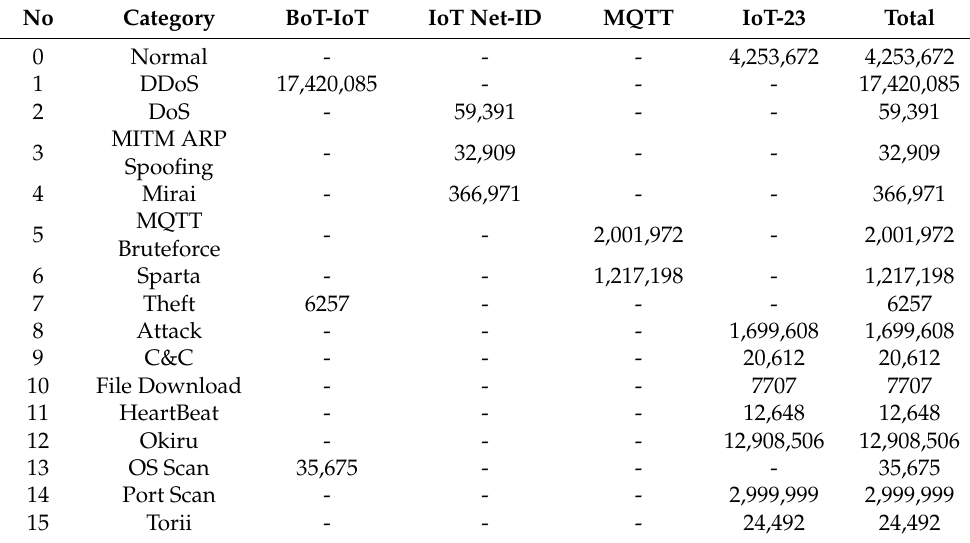
Table 7. IoT-DS-2 dataset